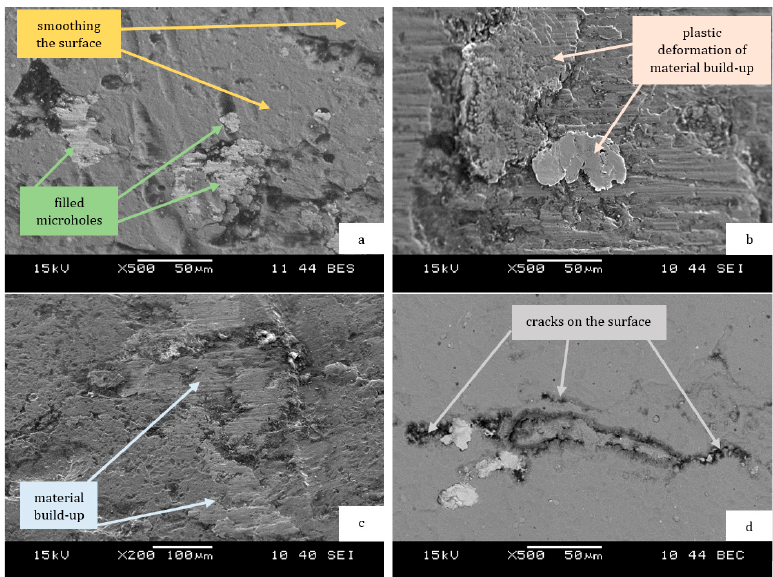
Figure 14. Scanning image of the shaft axle seat surface ( a ) after the forcing process; ( b – d ) at the place where fretting wear occurs.